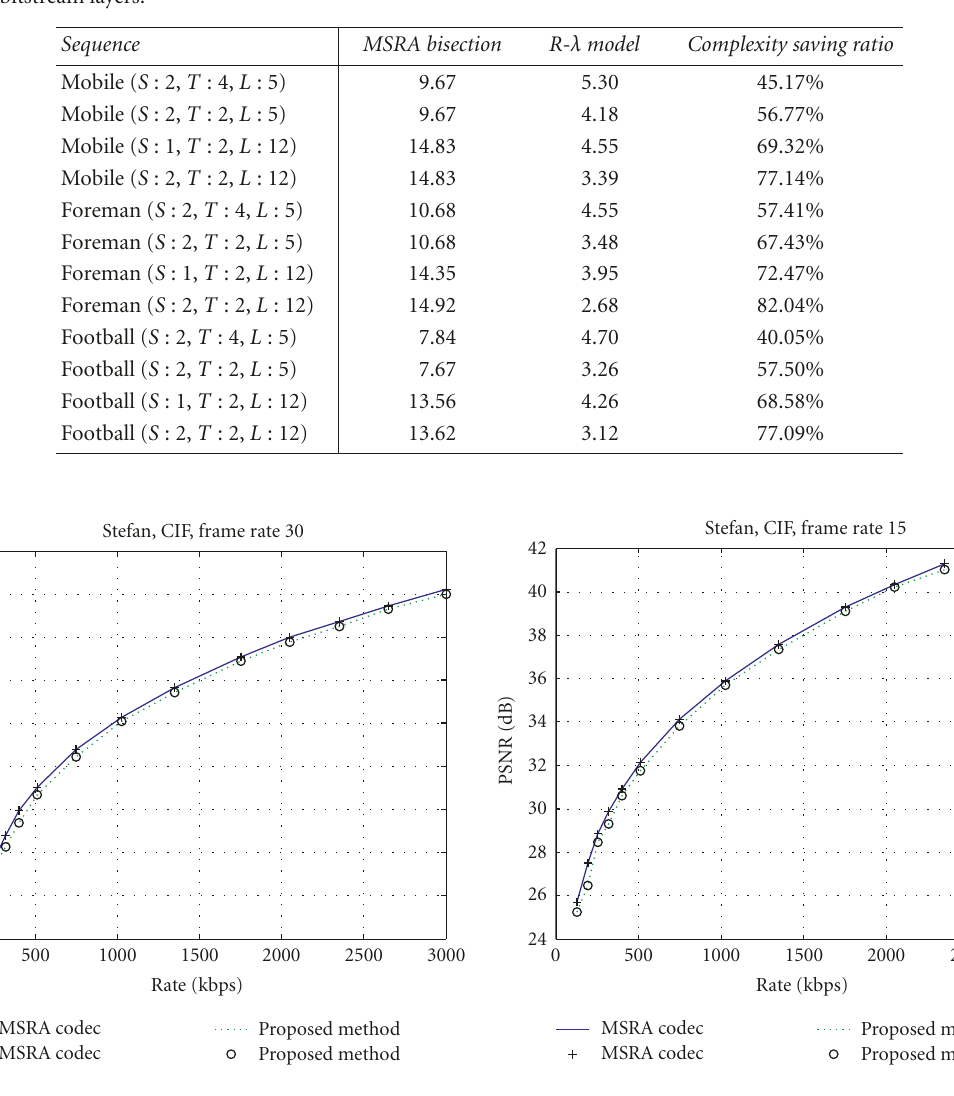
Table 1: Number of iterations for the MSRA and proposed approach. S is Number of spatial scalabilities, T is Number of temporal transform, L is Number of bitstream layers.